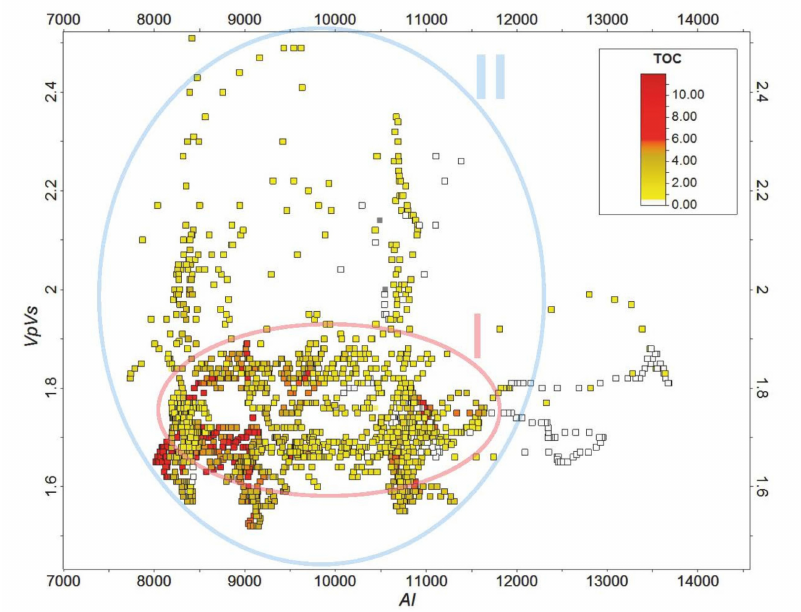
Figure 8. Acoustic impedance (AI) vs. V p / V s ratio as a function of TOC content within Source I (red circle) and Source II (blue